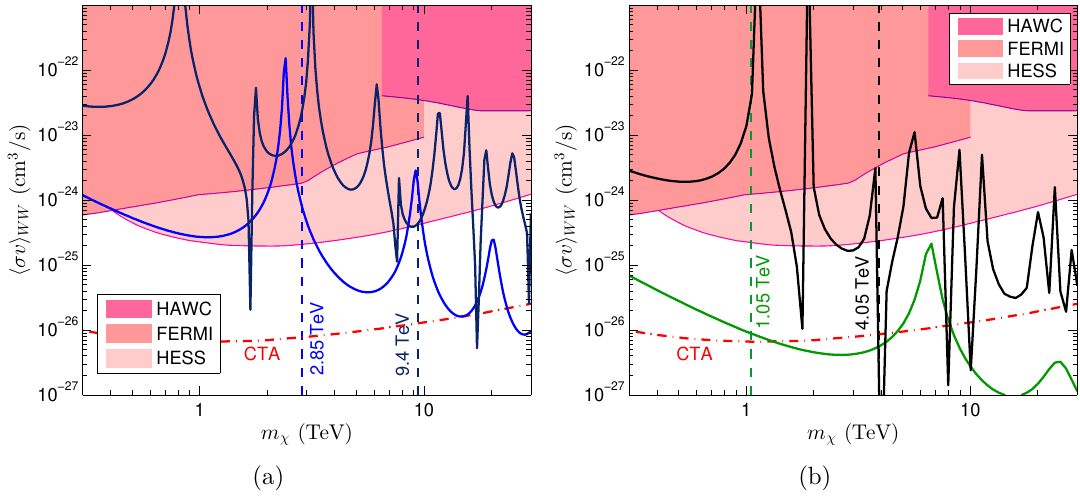
Figure 9. Constraints on predictions of the real (9(a)) and pseudo-real (9(b)) models of EWDM from inner galaxy observations. The predicted annihilation cross-sections into W + W − channel are plotted in solid line for real triplet (blue), real quintet (navy), complex doublet (green) and complex quartet (black). The overlaid lines from top to bottom indicate the observed limit for HAWC [99], Fermi [100], and HESS [101] data using NFW profile. The red dash-dotted line indicates sensitivity of CTA future experiment for NFW profile [102]. Where the cross-section curves enter the shaded areas, the corresponding mass values are excluded. Thermal DM masses are displayed by vertical dashed